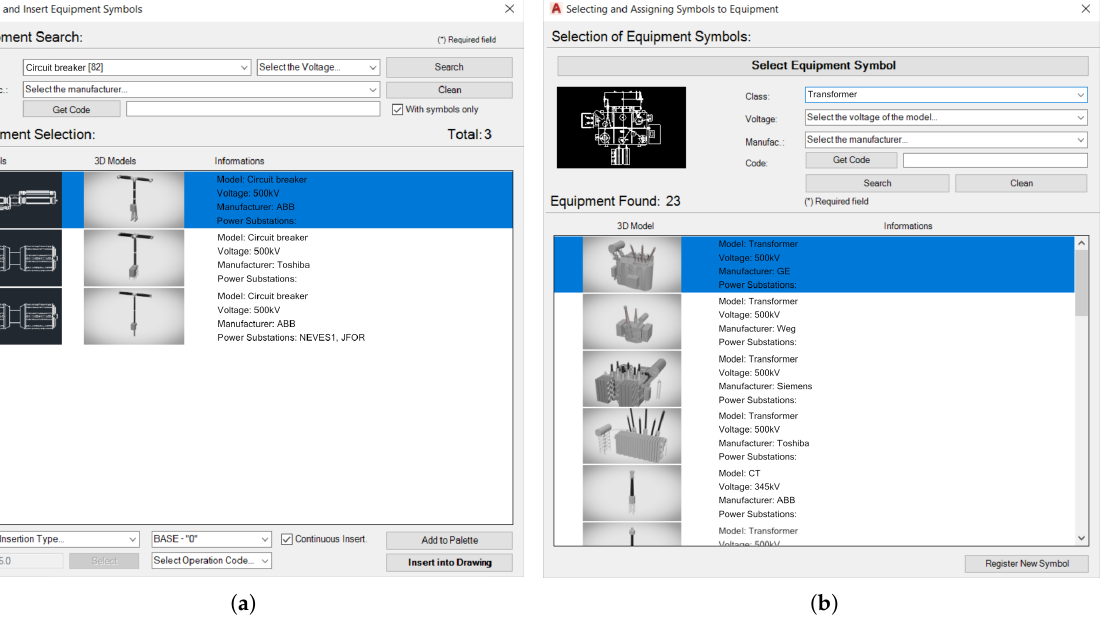
Figure 13. Examples of graphic interfaces on the CAD Editor: ( a ) search and symbol insertion tools, ( b ) symbol creation